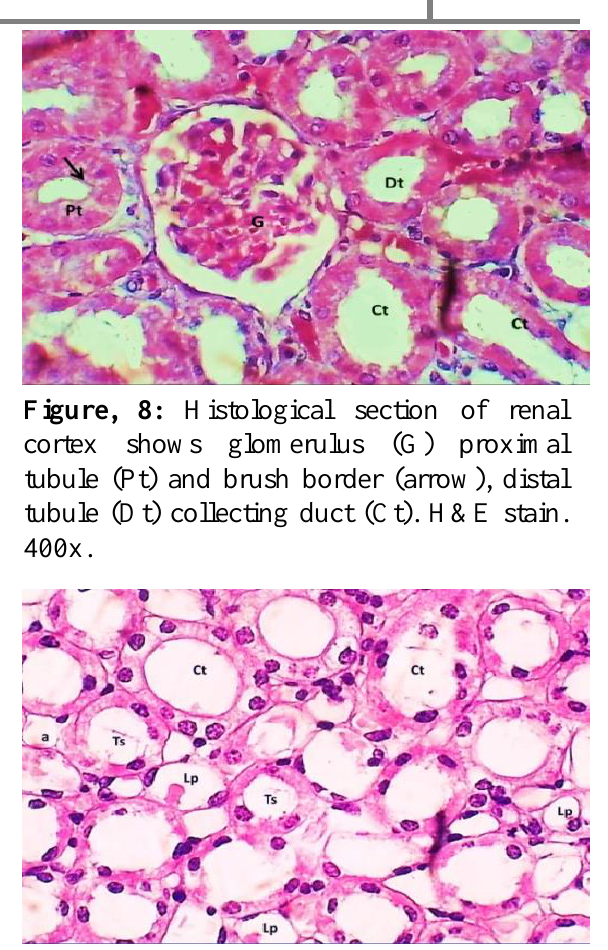
Figure, 9: Histological section of renal medulla shows: Collecting tubules (Ct), thick segments (Ts), thin segments (LP) of loop of henle and blood vessels (a). H&E stain. 400x.